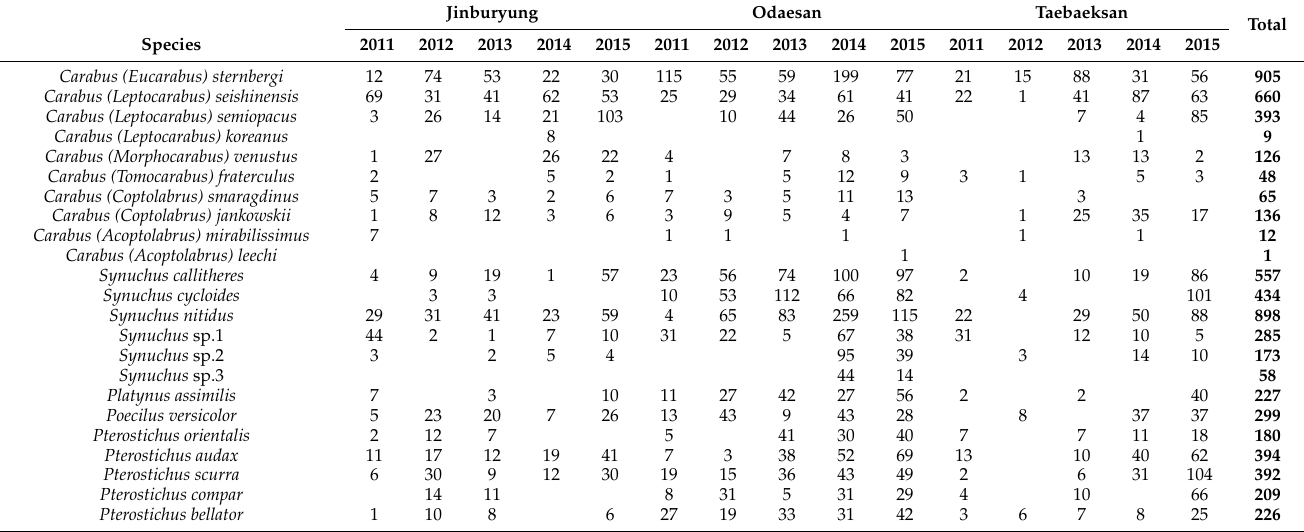
Table A2. Numbers of carabid beetles found on the Baekdudaegan Mountain Range, Korea, on three mountains, each sampled for two months per year over 5